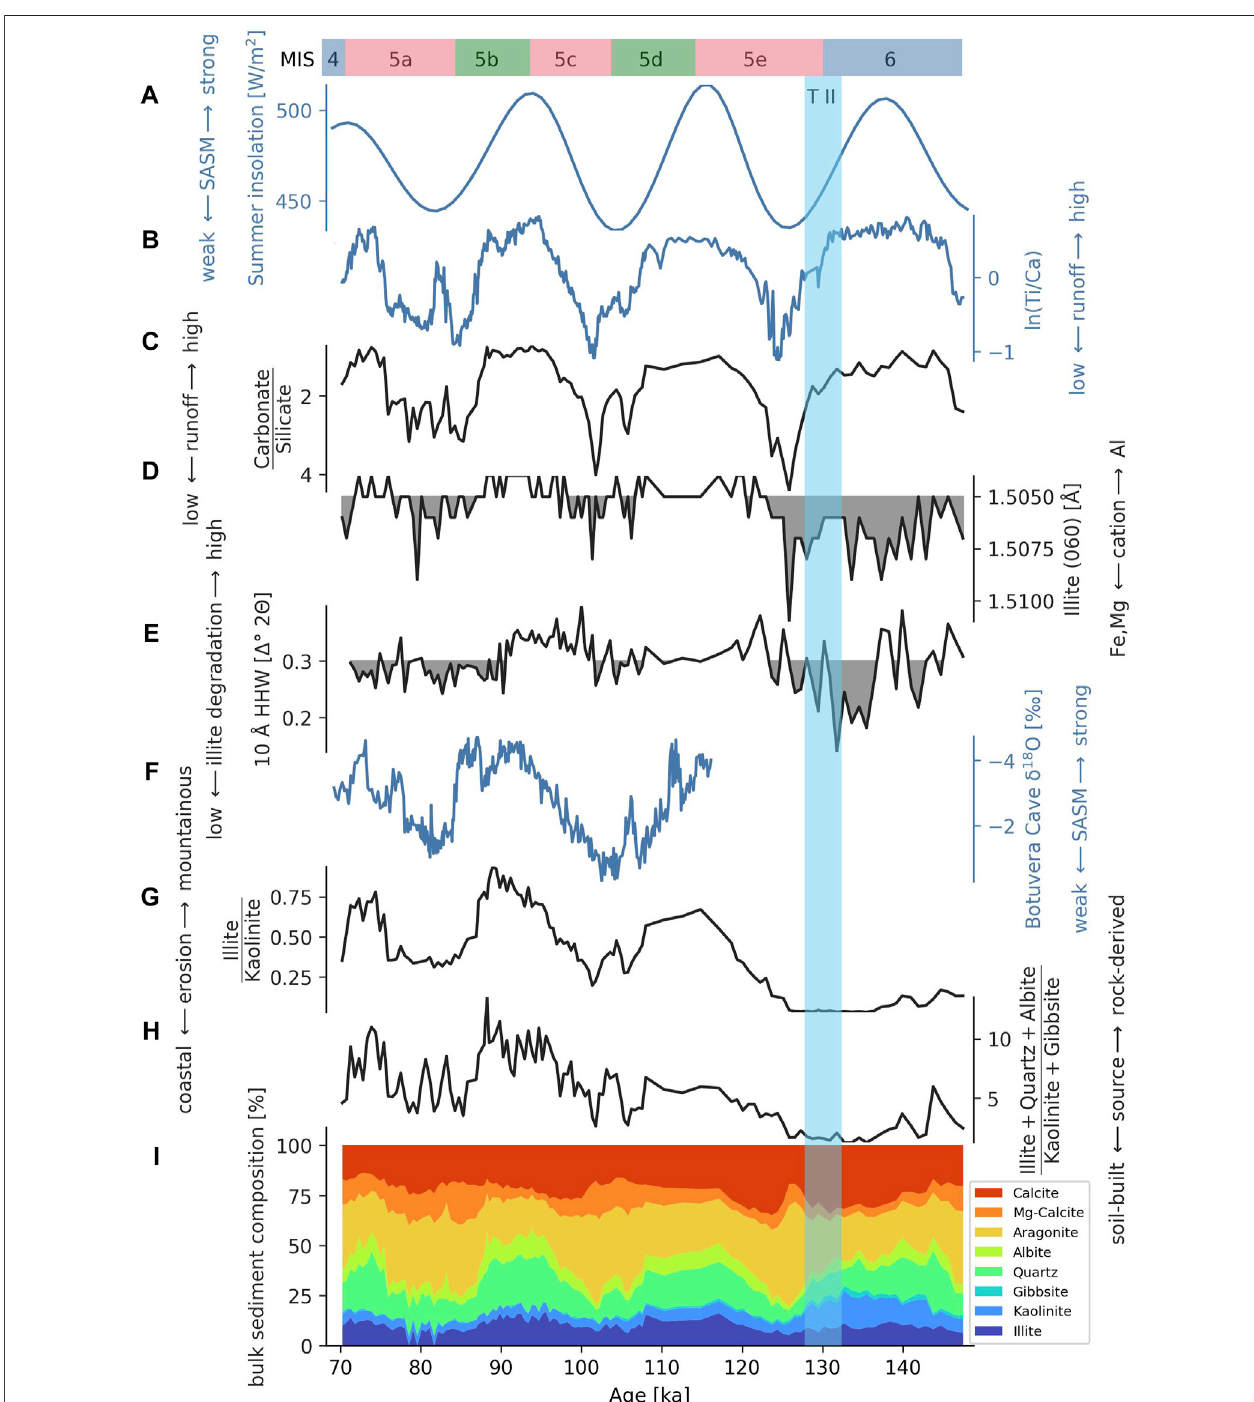
FIGURE4| Bulksedimentand riverderivedfraction XRDdatacompared to (A) thesummerinsolation curveat20 ° S(Laskaretal.,2004), (B) ln(Ti/Ca)ratiosbased on x-ray fl uorescence scanning of Core M125-55-7 (Hou et al., 2020a). (C) The carbonate to silicate ratio is calculated from the bulk sediment measurements and indicatestherelativedischargeofterrestrialmaterialthroughrunoff.Duringhighinsolationphases,dischargeisenhanced. (D) The(060)peakaround1.50 Å(texturefree clay fraction) indicates the proportion of different elements occupying the octahedra cation position in illite, with Fe 2+ and Mg 2+ indicating wider spacing and Al 3+ lowerspacing.Valuesabove1.505 Åareshaded.Al-richillitesaremoreabundantinphasesofhighdischargeinMIS5. (E) Thewidthoftheofthe10 Åillitepeakathalfof itsmaximumheightisexpressedasthehalfheightwidth(HHW)withinthetexturedclayfractions.Valuesbelow0.3 Δ ° 2 Θ areshaded.Brought10 Åpeaksindicatehigher degradationorlowercrystallinity,occurringpredominantly inhighinsolationphases. (F) δ 18 OvaluesfromtheBotuveráCave(cavelocationsee Figure1 )fromCruzetal.